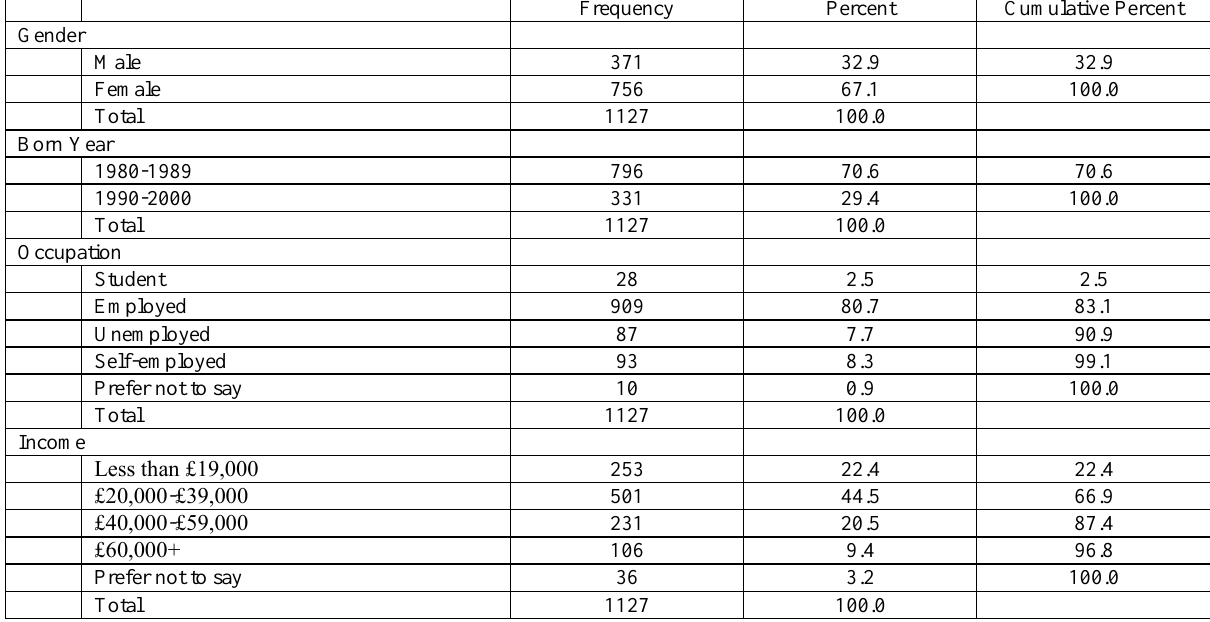
Table 1. Data profile for the